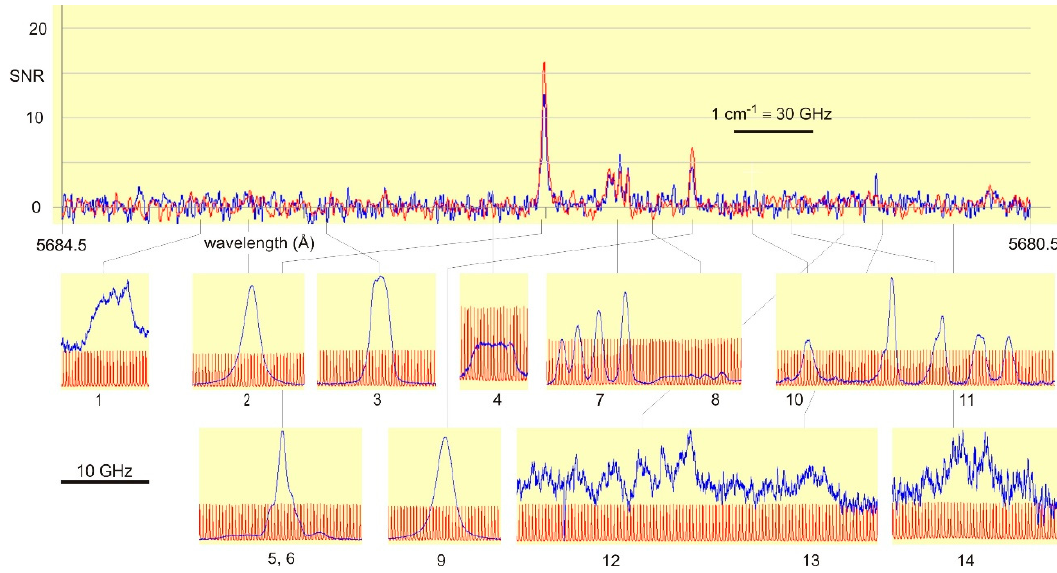
Figure 2. Comparison of the available FT spectrum [8] (two overlapped spectra under different discharge conditions shown in red and blue) and optogalvanic spectra in the same wavelength range. In the OG spectra the red trace is the transmission signal of a marker etalon with free spectral range of 367.3 MHz. The OG spectra are normalized to the same amplitude, even their SNR is quite different.